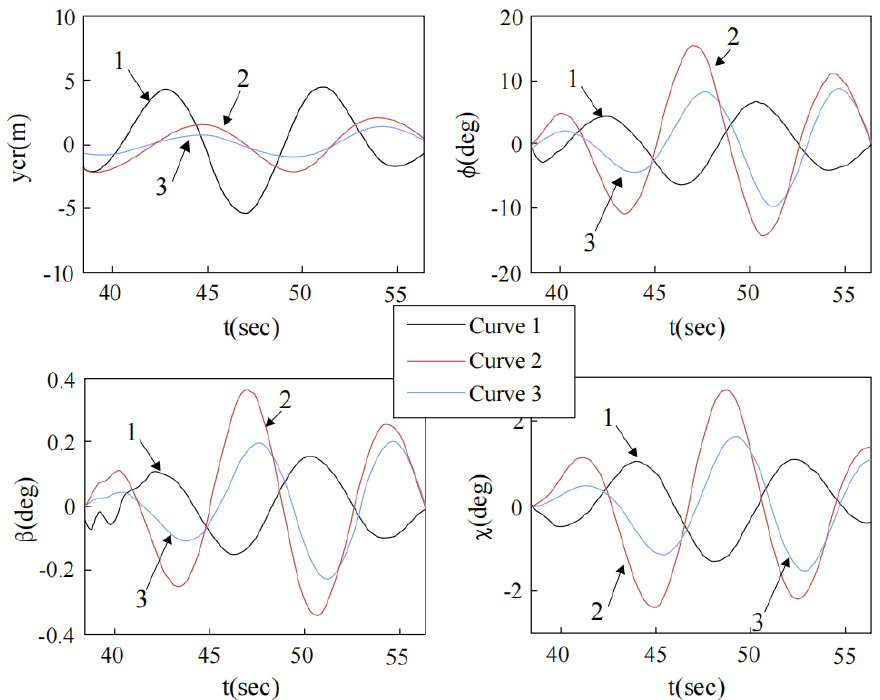
Figure 41. The deck motion compensation curves under inertial tracking strategies with different static coefficients of k values.